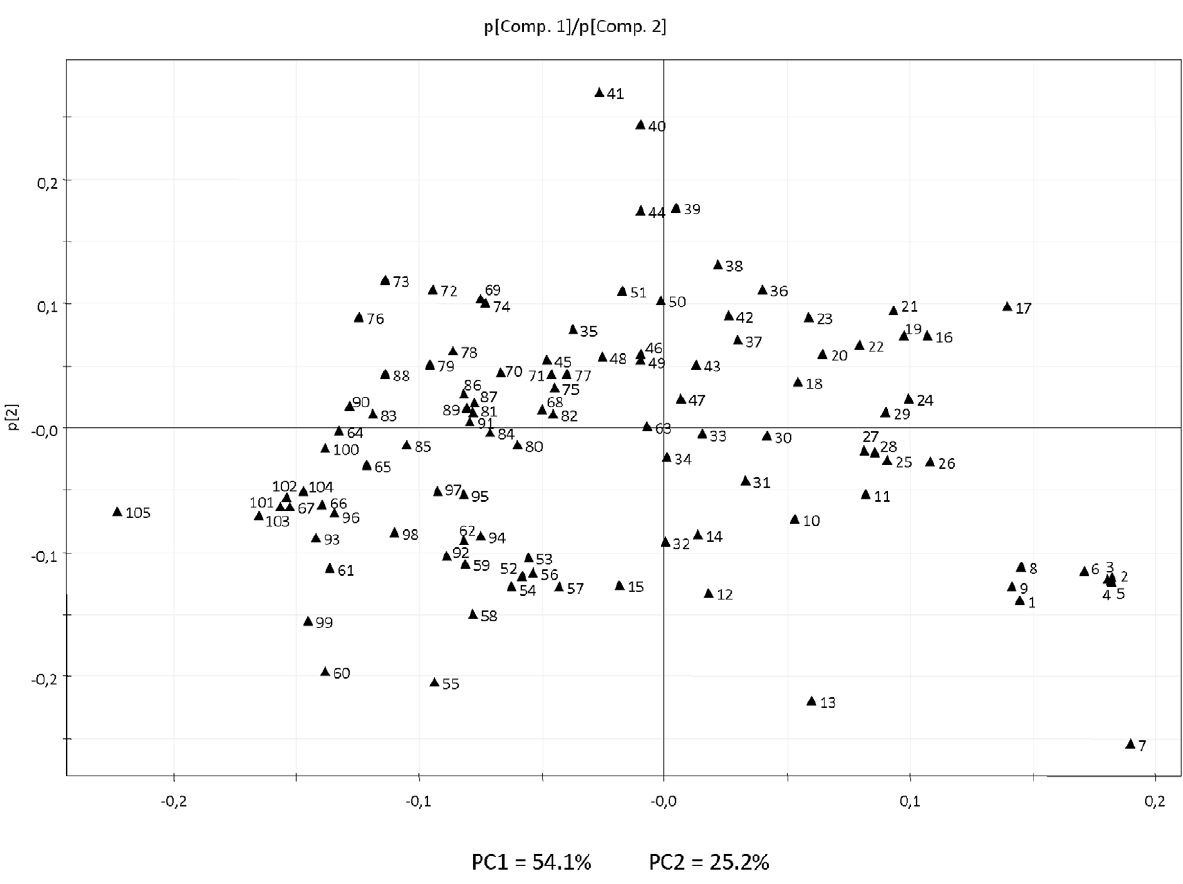
Figure 2. Principal Component Analysis loading plot (p[1] vs p[2]) for the first and second principal components. Each number corresponds to a particular volatile compound, as indicated in Table 1.